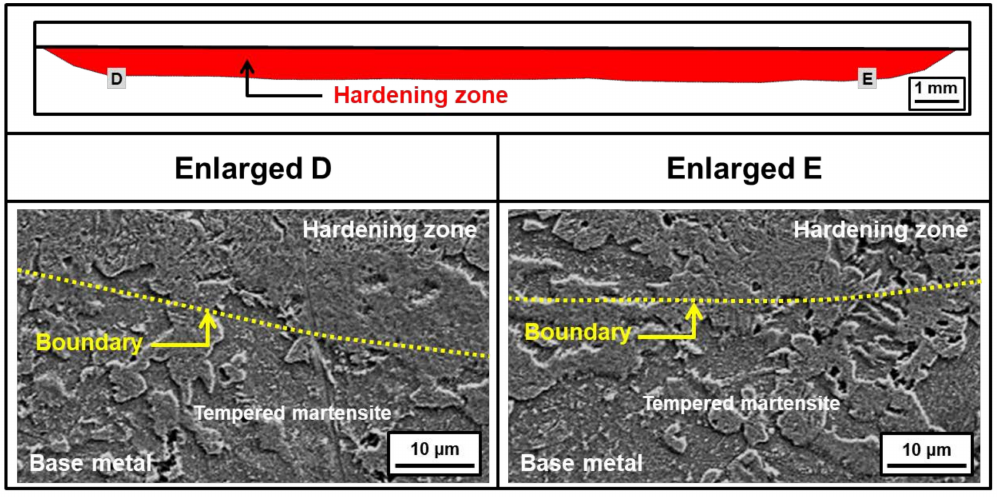
Figure 12. SEM micrographs of the boundary between the hardening zone and the base metal region of P20-improved steel after laser-assisted heat treatment at 1473